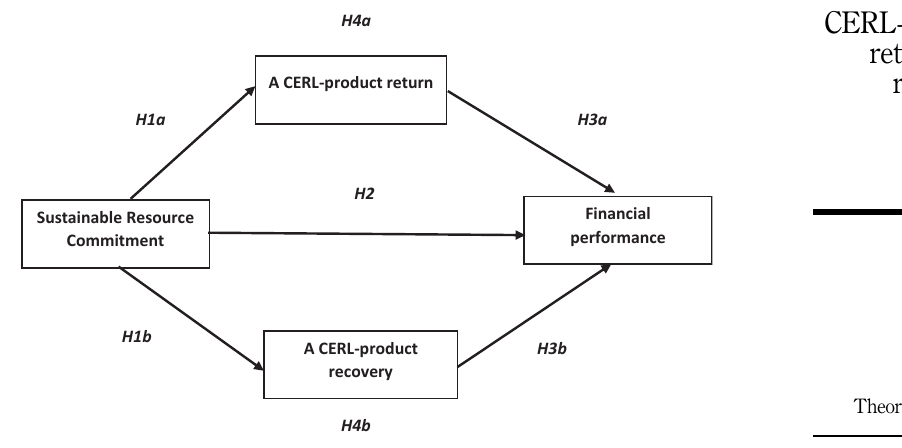
Figure 1. Theoretical